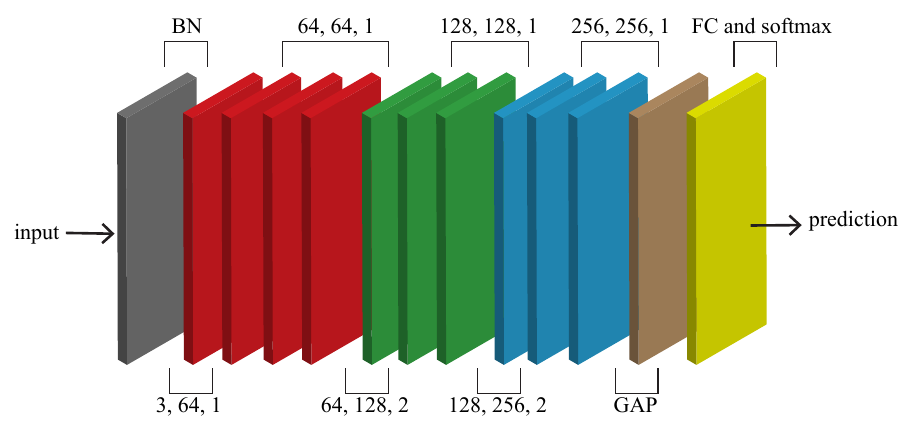
Figure 6. The architecture of